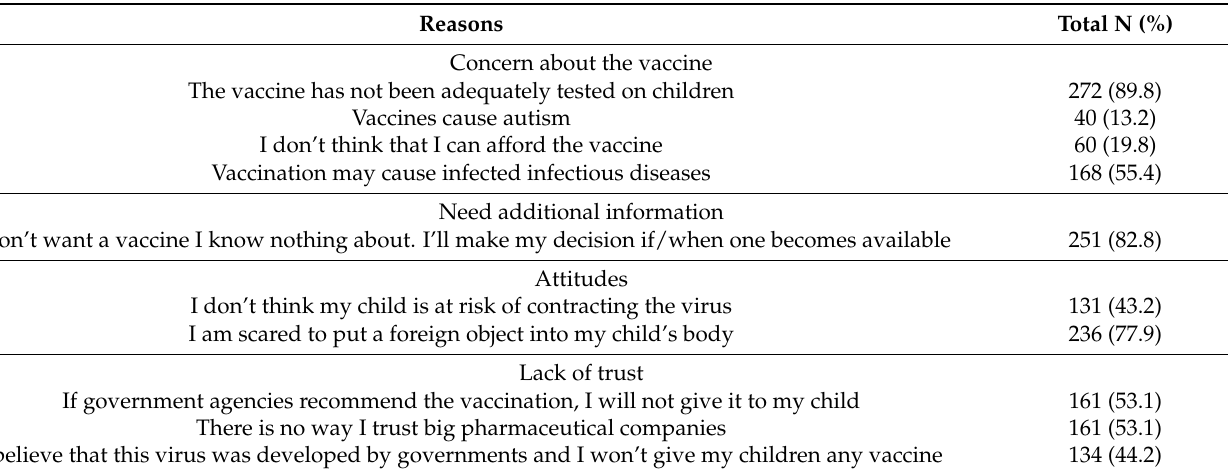
Table 4. Reasons for a participant’s responding “No” or “Not sure” to the question about